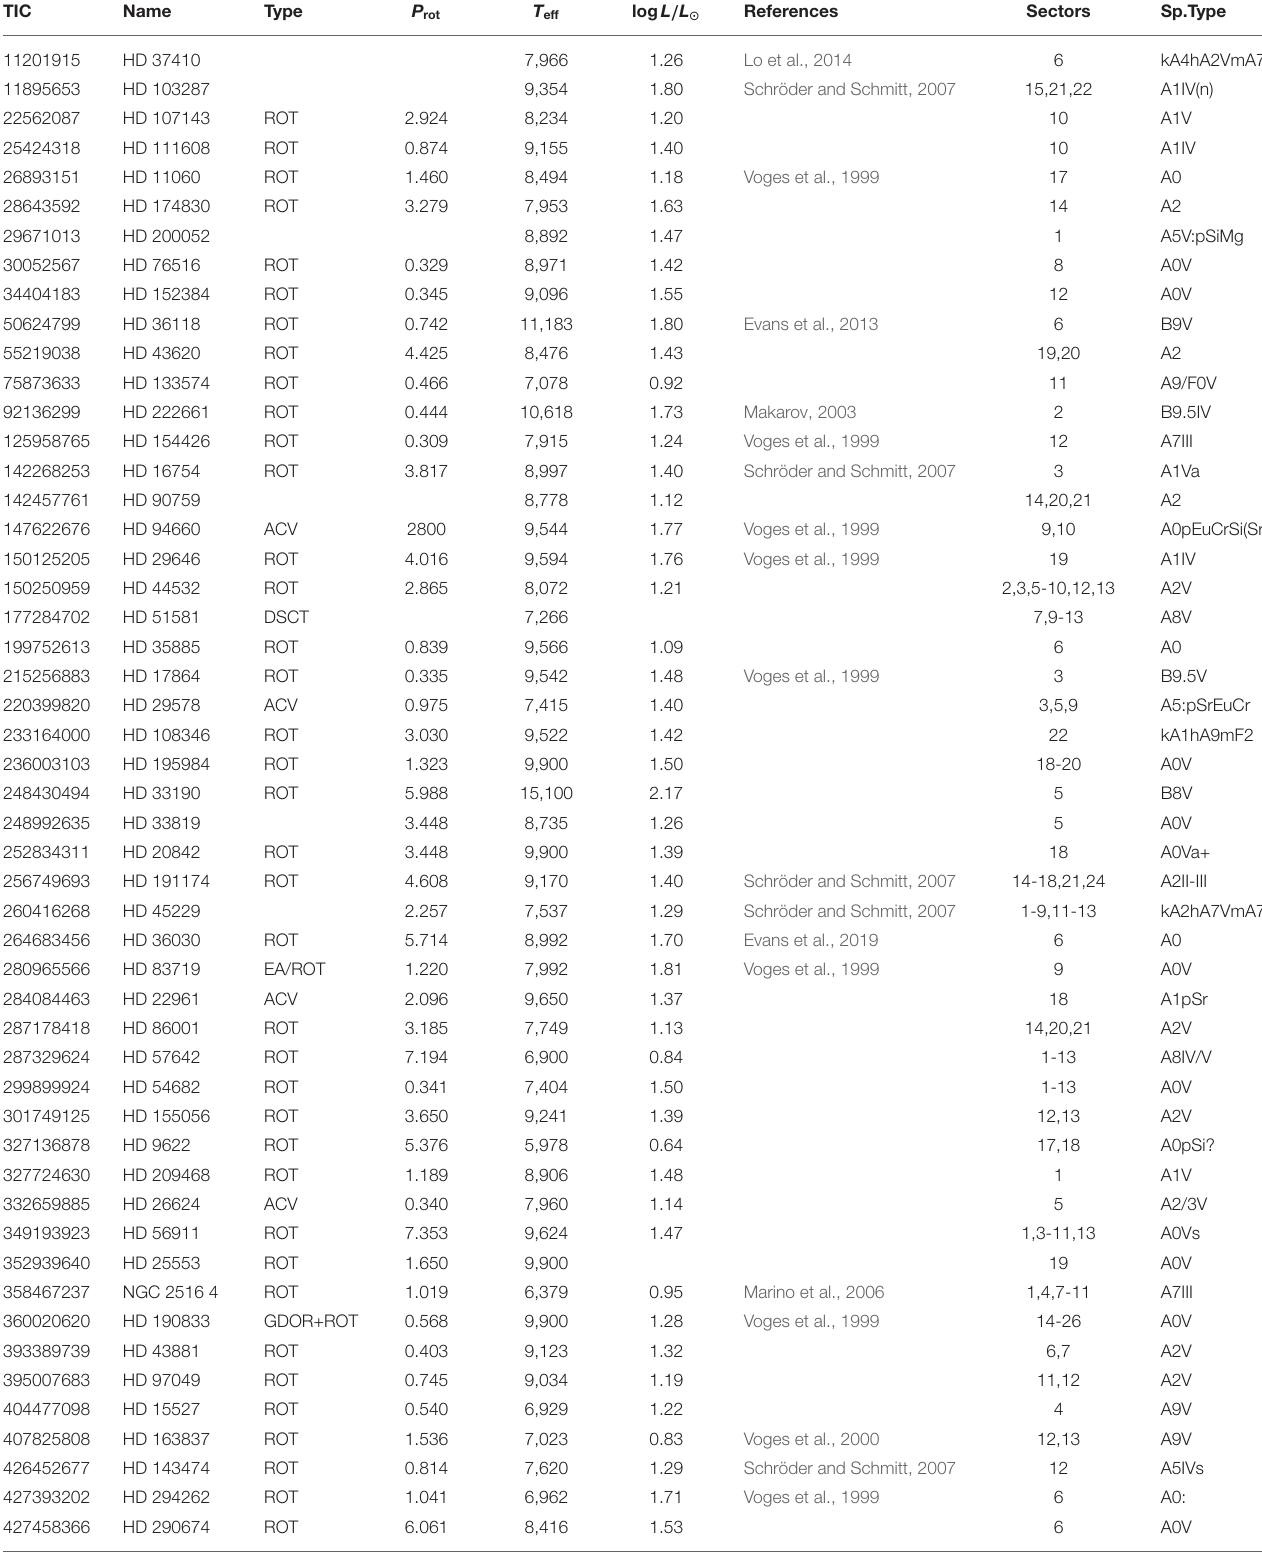
TABLE 2 | Flare stars detected from visual inspection of TESS light